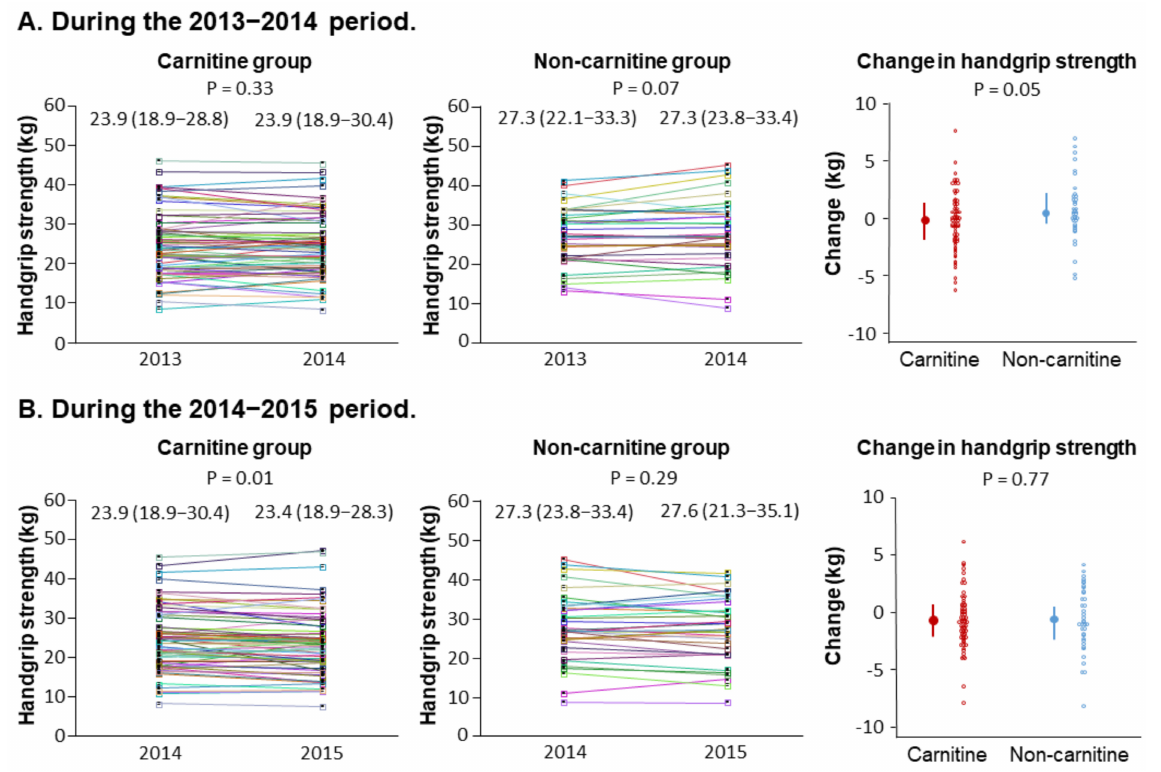
Figure 3. Changes in handgrip strength. The graphs show individual measurements of handgrip strength in the carnitine and non-carnitine groups and the between-group comparison of the one-year changes during the 2013–2014 period ( A ) and during the 2014–2015 period ( B ). In the carnitine group, treatment with levocarnitine was done only in the period from 2014 and 2015. The error bars represent interquartile